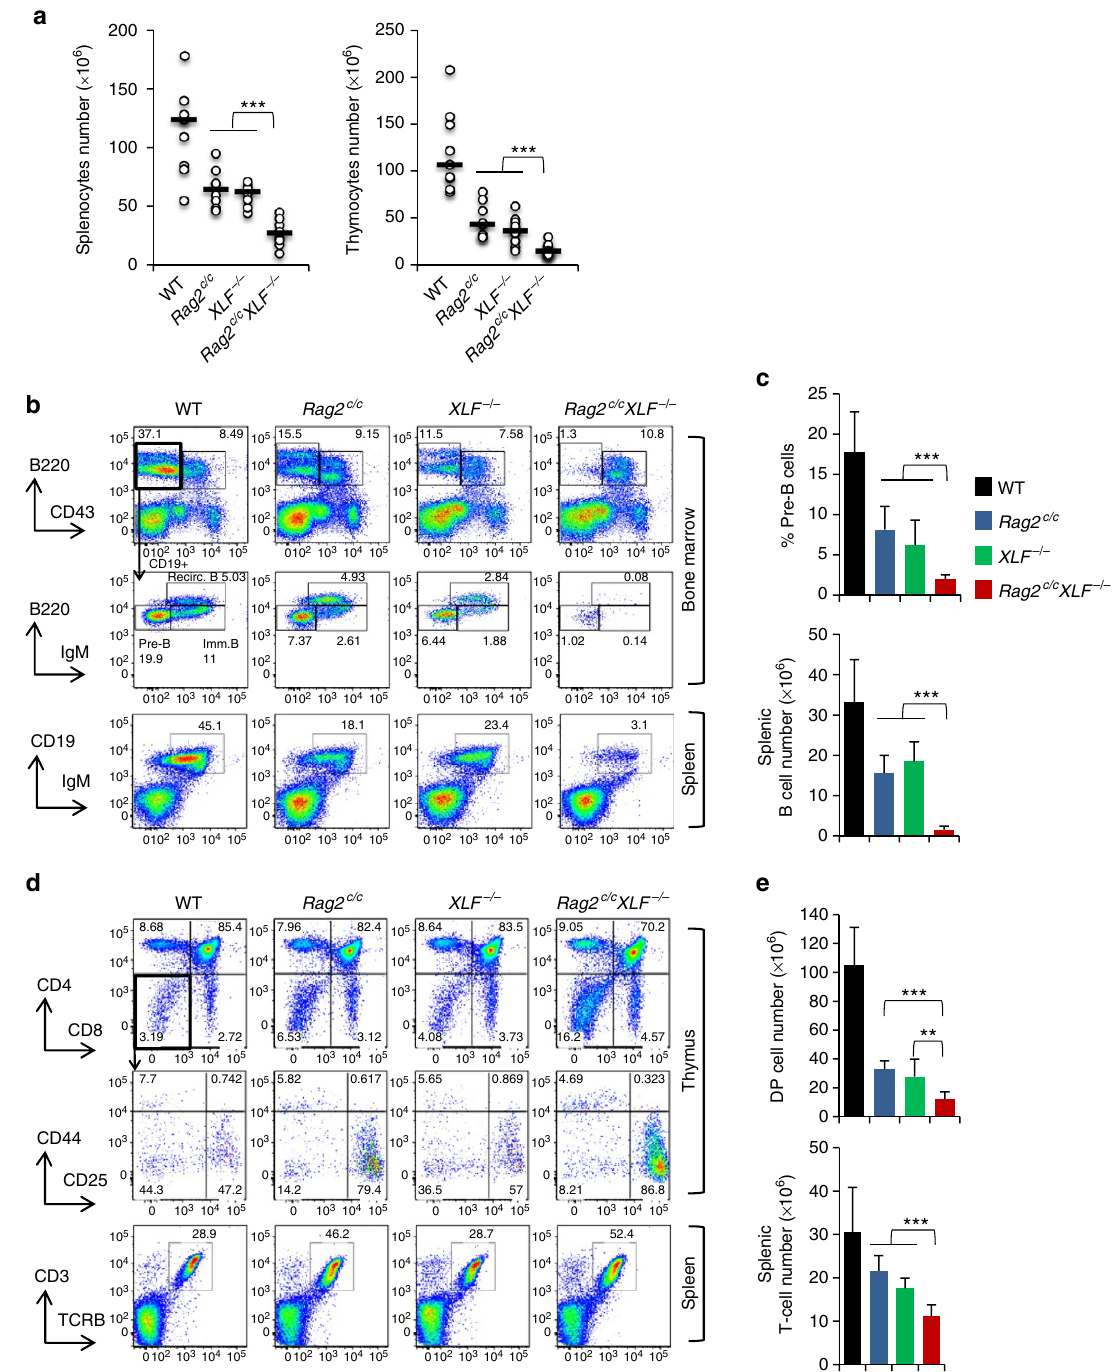
Figure 1 | Lymphopenia associated with severe B cell developmental block in Rag2 c/c XLF (cid:2) / (cid:2) mice. Lymphocyte development in WT, Rag2 c/c , XLF (cid:2) / (cid:2) and Rag2 c/c XLF (cid:2) / (cid:2) mice. ( a ) Total splenocyte (left) and thymocyte (right) numbers. Each dot represents one mouse and bars indicate the median. ( b , c ) Analysis of B cell development. ( b ) Representative FACS analysis of bone marrow and spleen using B cell markers. Numbers on plots represent percentages of total cells. ( c ) Percentage of bone marrow CD43 (cid:2) B220 lo CD19 þ IgM (cid:2) pre-B cells (upper) and total number of splenic CD19 þ IgM þ B cells (bottom). ( d , e ) Analysis of T-cell development. ( d ) Representative FACS analysis of thymus and spleen using T-cell markers. ( e ) Total number of thymic DP cells (upper) and splenic CD3 þ TCR b þ T cells (bottom). Histograms represent means ± s.d. from at least five mice of each genotype. **0.001 r P o 0.01, *** P o